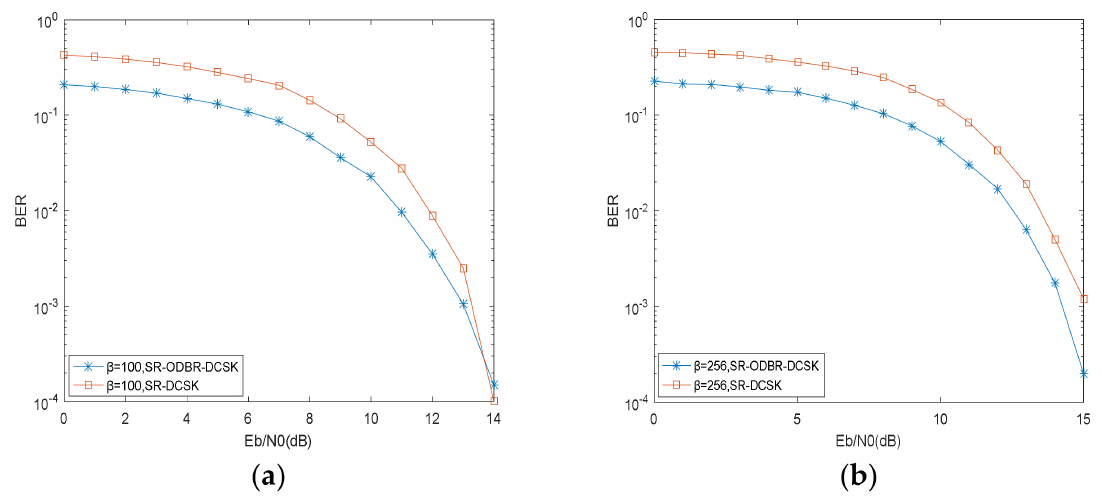
Figure 9. Comparison of BER of the SR-DCSK system and the SR-ODBR-DCSK system. ( a ) β = 100 ; ( b ) β = 256.